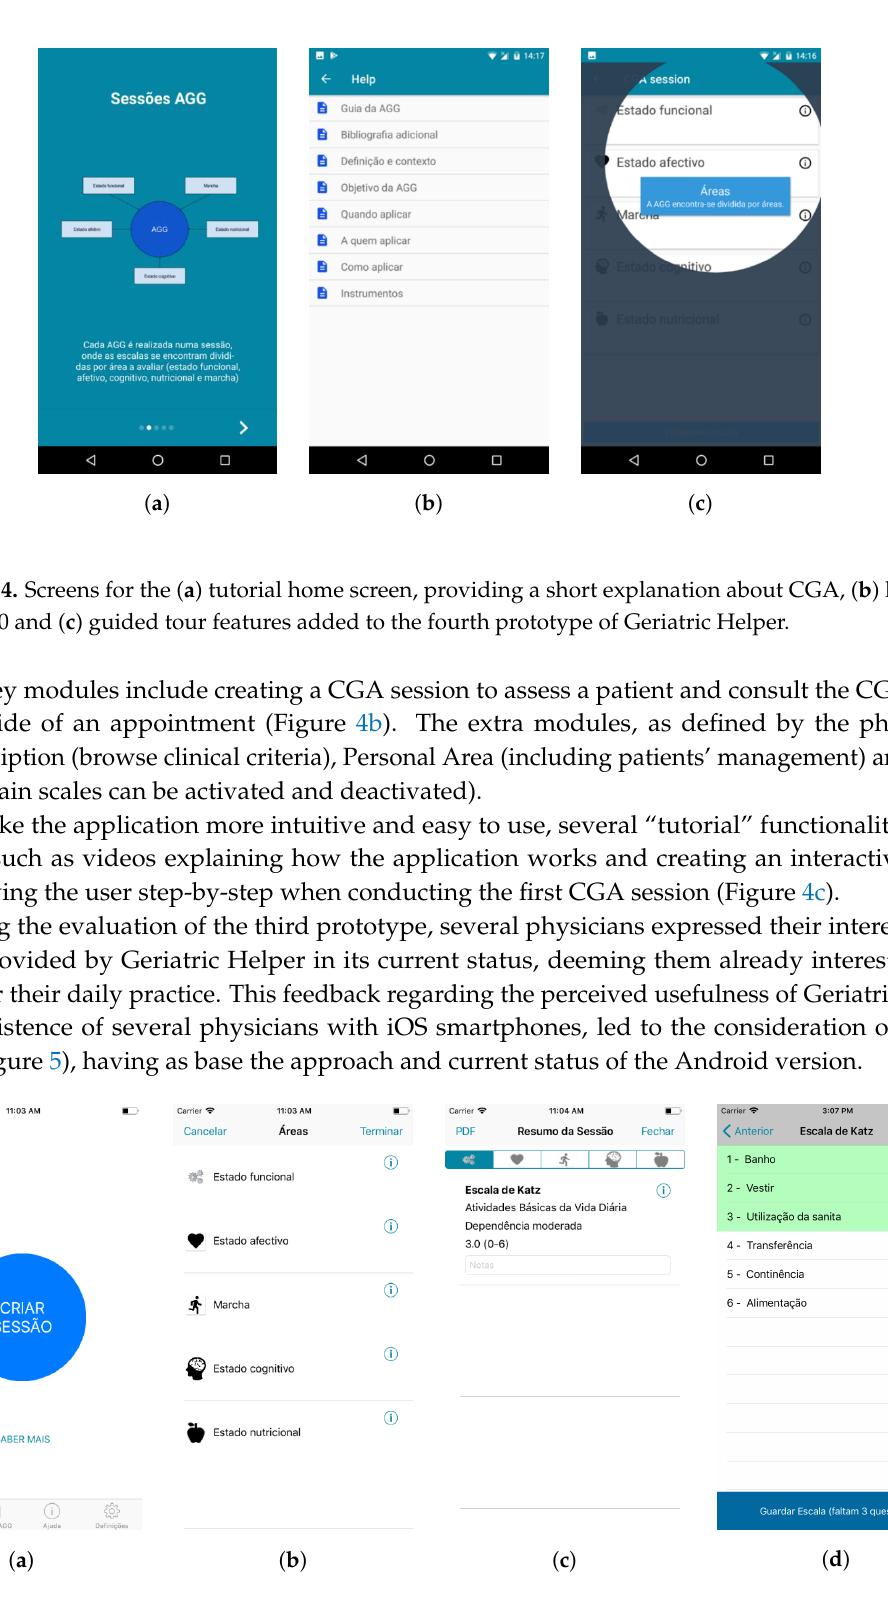
Figure 5. Geriatric Helper for iOS: ( a ) start screen; ( b ) menu of the different dimensions that can be assessed; ( c ) reviewing the outcomes of the ongoing assessment session; ( d ) items to be assessed in a